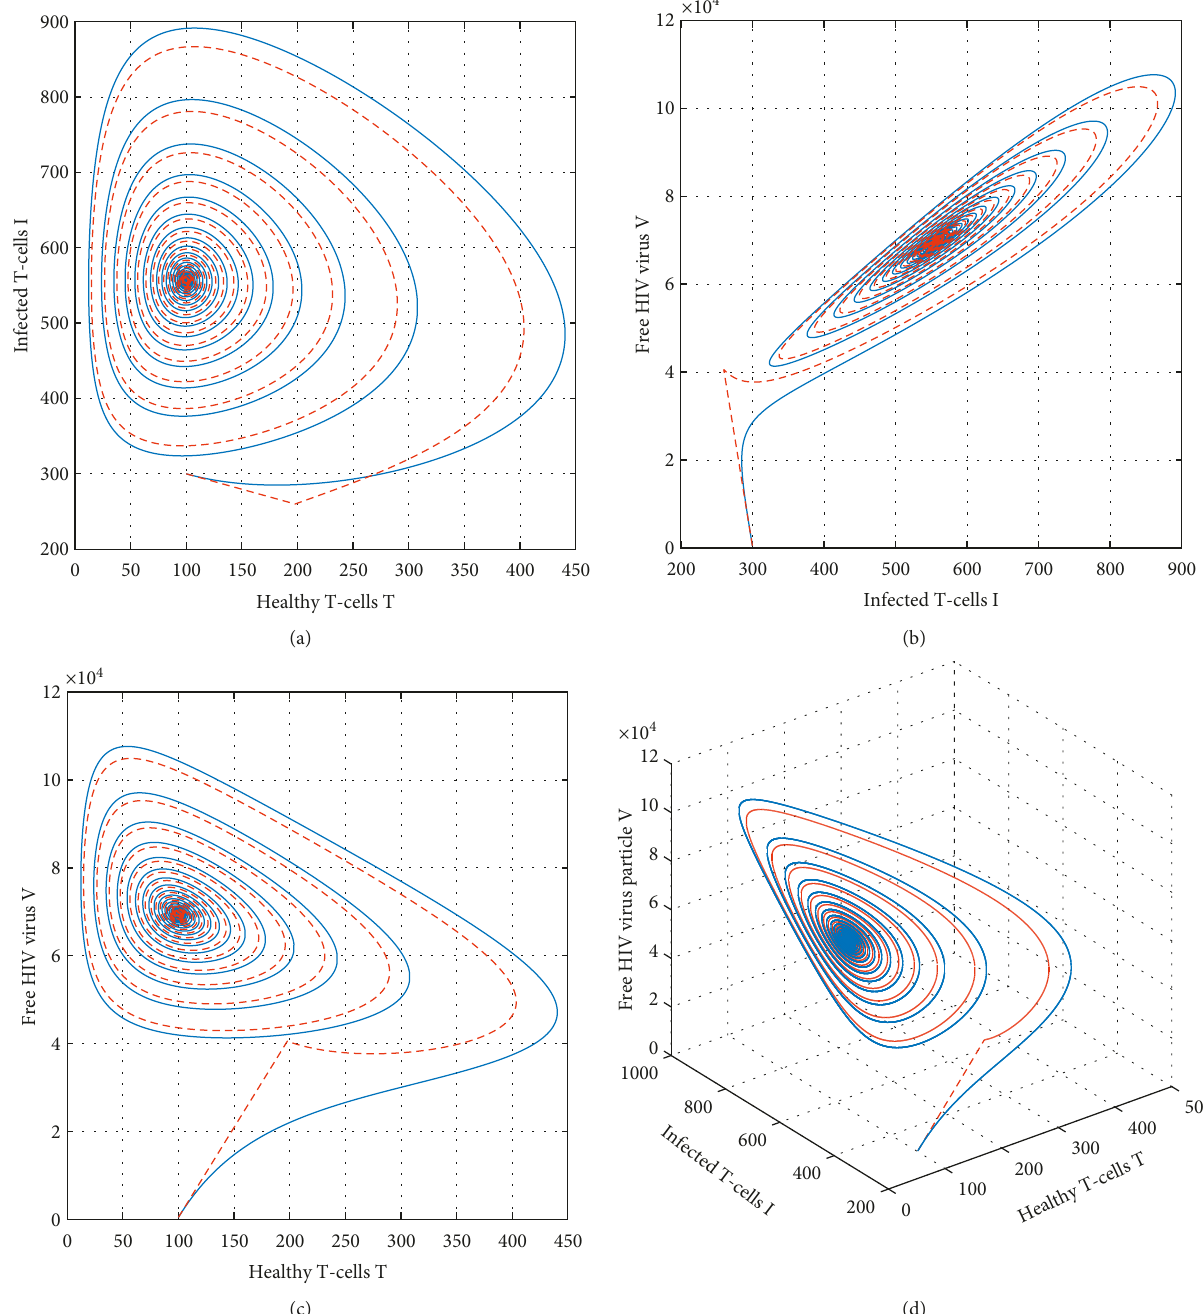
Figure 6: Graphical view analysis of the chaotic phenomena of the suggested fractional model (2) of HIV with the index of memory ϑ � 0 .